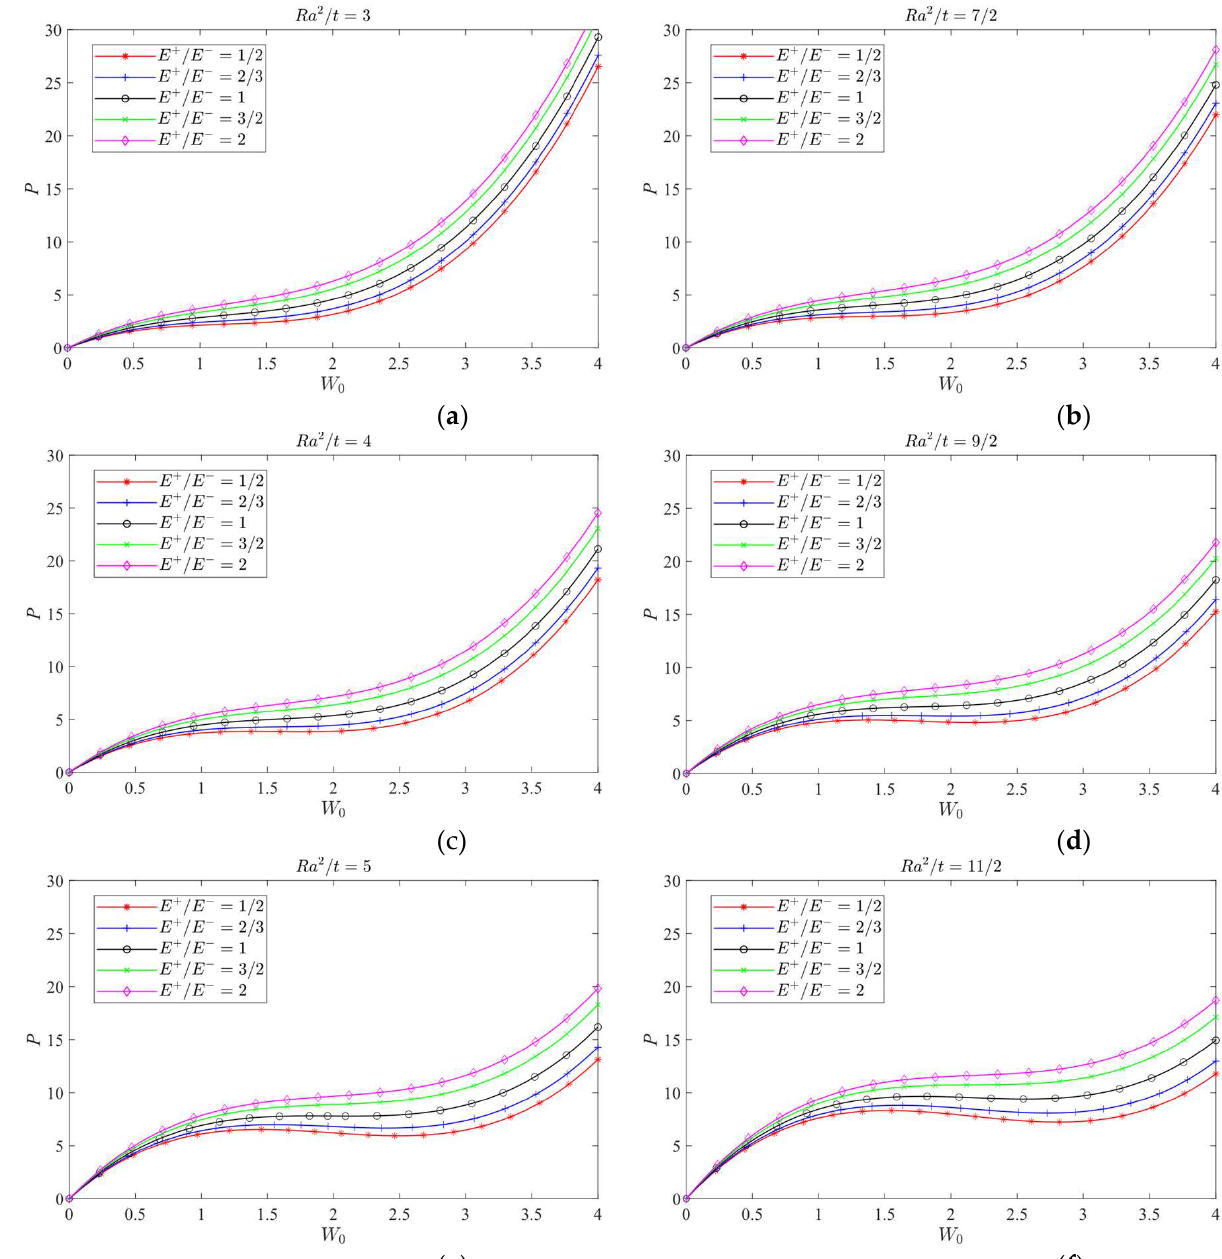
Figure 11. Load vs. central deflection when λ = 1/2. ( a ) Ra 2 / t = 3; ( b ) Ra 2 / t = 7/2; ( c ) Ra 2 / t = 4; ( d ) Ra 2 / t = 9/2; ( e ) Ra 2 / t = 5; ( f ) Ra 2 / t = 11/2.